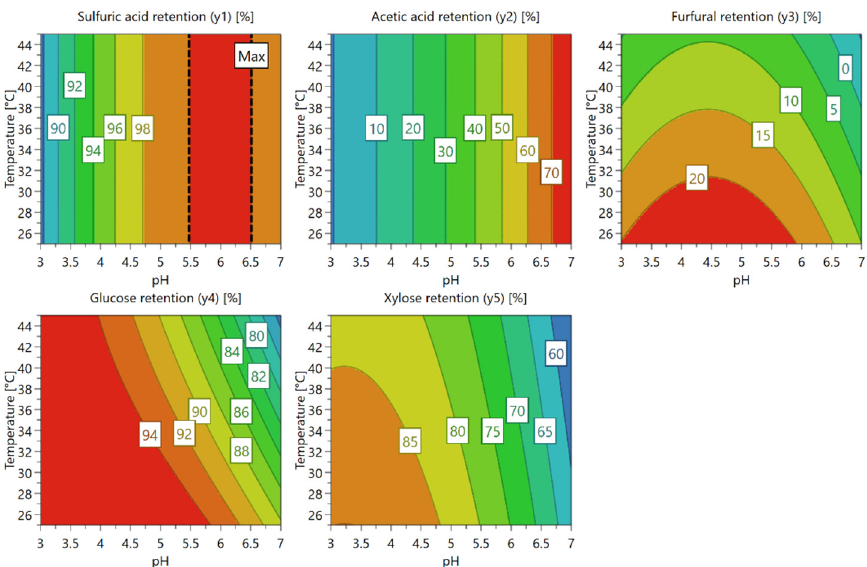
Figure 4. Response contour plots for each response.